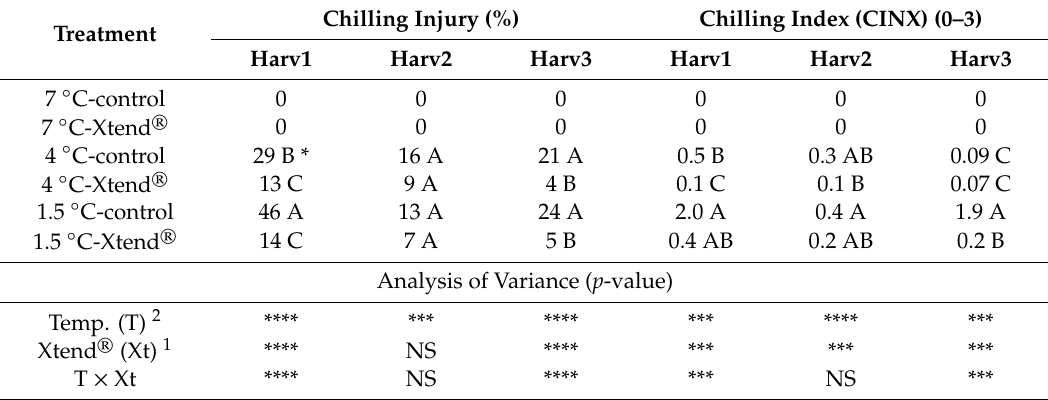
Table 2. The e ff ects of di ff erent temperatures and packaging (Xtend ® bag) on yellow pepper fruit, cv. Dinamo, in terms of chilling injury and chilling index (0–3) after 21 days of storage at di ff erent low temperatures, followed by 3 days of storage at 21 ◦ C. Chilling Injury (%) Chilling Index (CINX) (0–3) Treatment Harv1 Harv2 Harv3 Harv1 Harv2